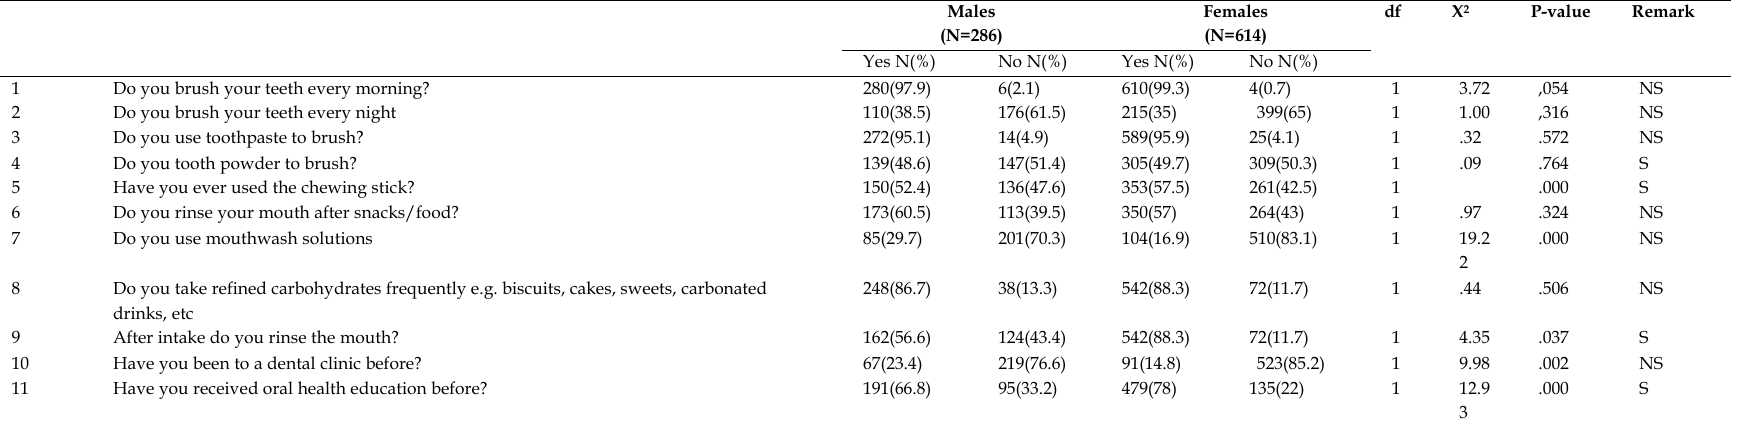
Table 3: Chi-square analysis on the difference in the preventive measures adopted by the Senior Secondary School students based on gender